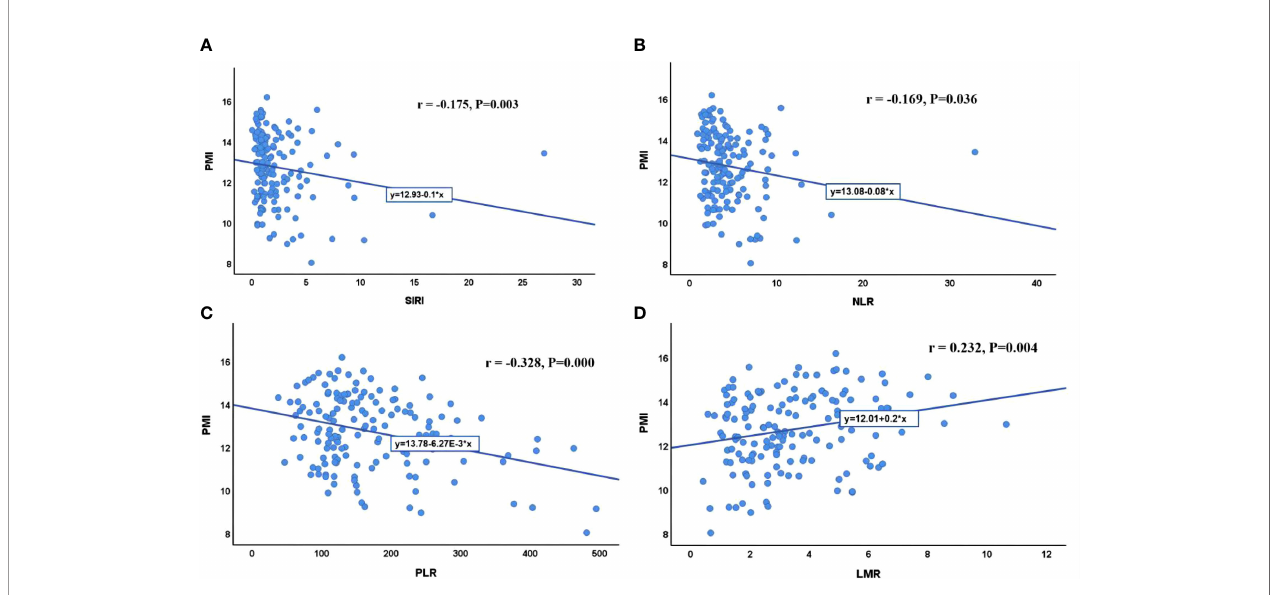
FIGURE 5 | Correlation between PMI and in fl ammatory indicators. (A) Correlation between PMI and SIRI; (B) Correlation between PMI and NLR; (C) Correlation between PMI and PLR; (D) Correlation between PMI and LMR. SIRI, systemic in fl ammatory response index; NLR, neutrophil-to-lymphocyte ratio; PLR, platelet-to-